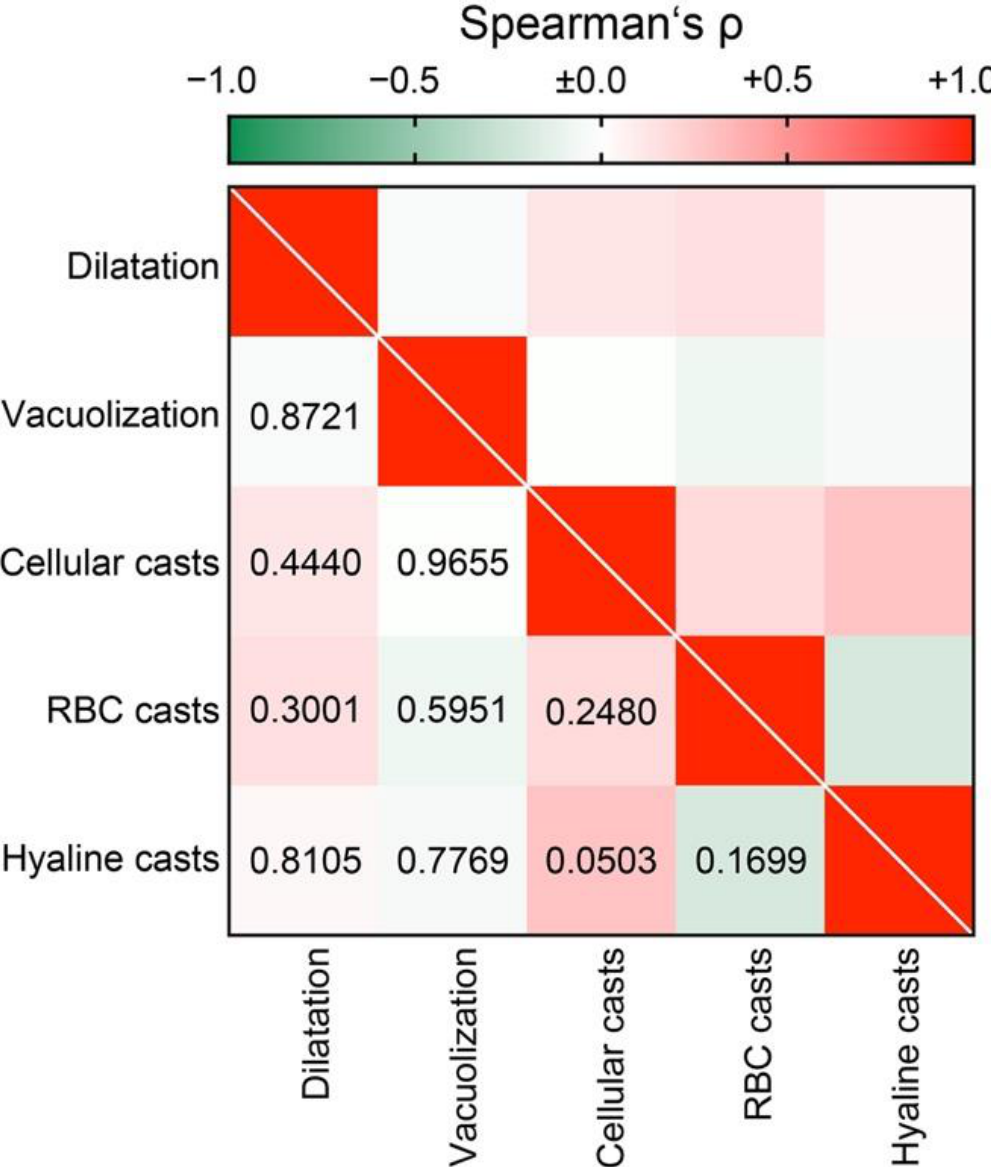
Figure 3. Direct association between tubular injury lesions in AAV: Association between distinct tubular injury lesions are shown by heatmap reflecting mean values of Spearman’s ρ , values of p are shown for each association. Abbreviations: AAV, ANCA-associated vasculitis; RBC, red blood cell.